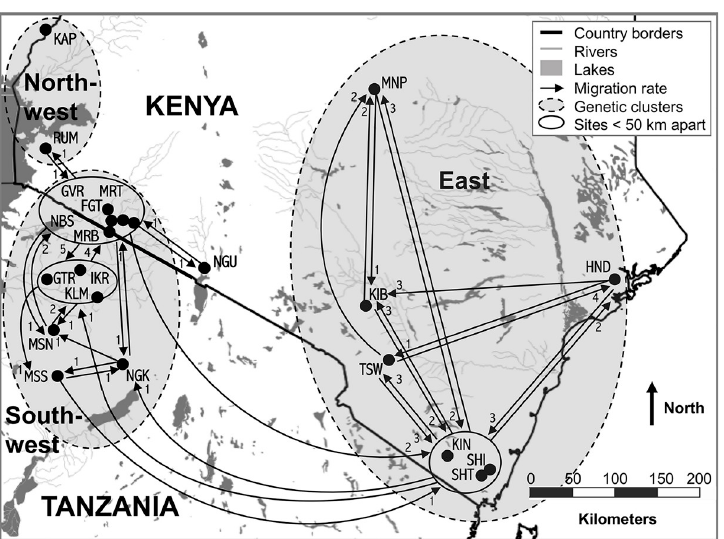
Fig 4. First generation migrants among sampling sites. Migrants detected using the software GENECLASS [70] indicated with arrows pointed in the direction of movement. Sites were grouped together if less than 50 km apart. Each dot represents a sampling site labeled with site codes (Table 1). The dashed outlines denote the three genetic clusters identified in BAPS v 6 [55,56].The map was created in QGIS v2.12.1 (August 2017; http://qgis.osgeo.org) with free and publicly available data available from DIVA-GIS (August 2017; http://www.diva-gis.org).